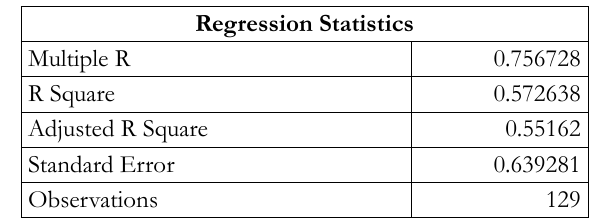
Table 13. Regression statistics of Incentives for lecturers and students against increased usage of ICTs ANOVA df SS